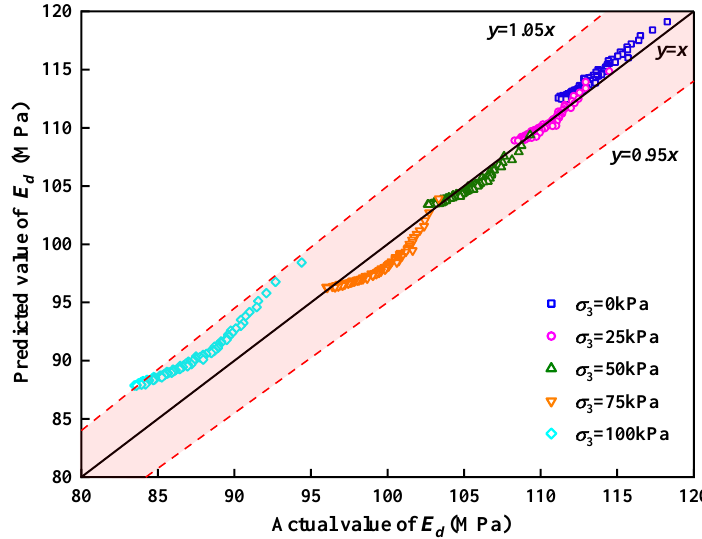
Figure 16. Comparison of actual and predicted E d .